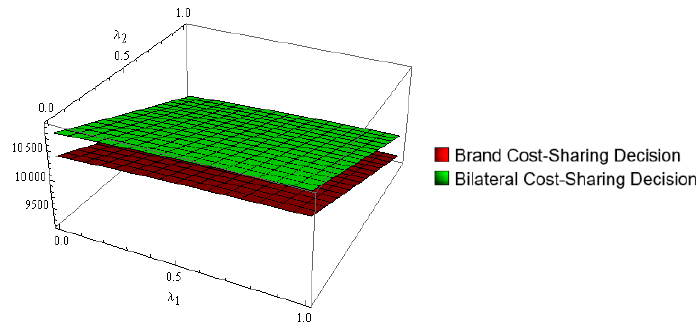
Figure 9. Impact of λ i on the Retailer’s Profit When P 1 < P ∗ .